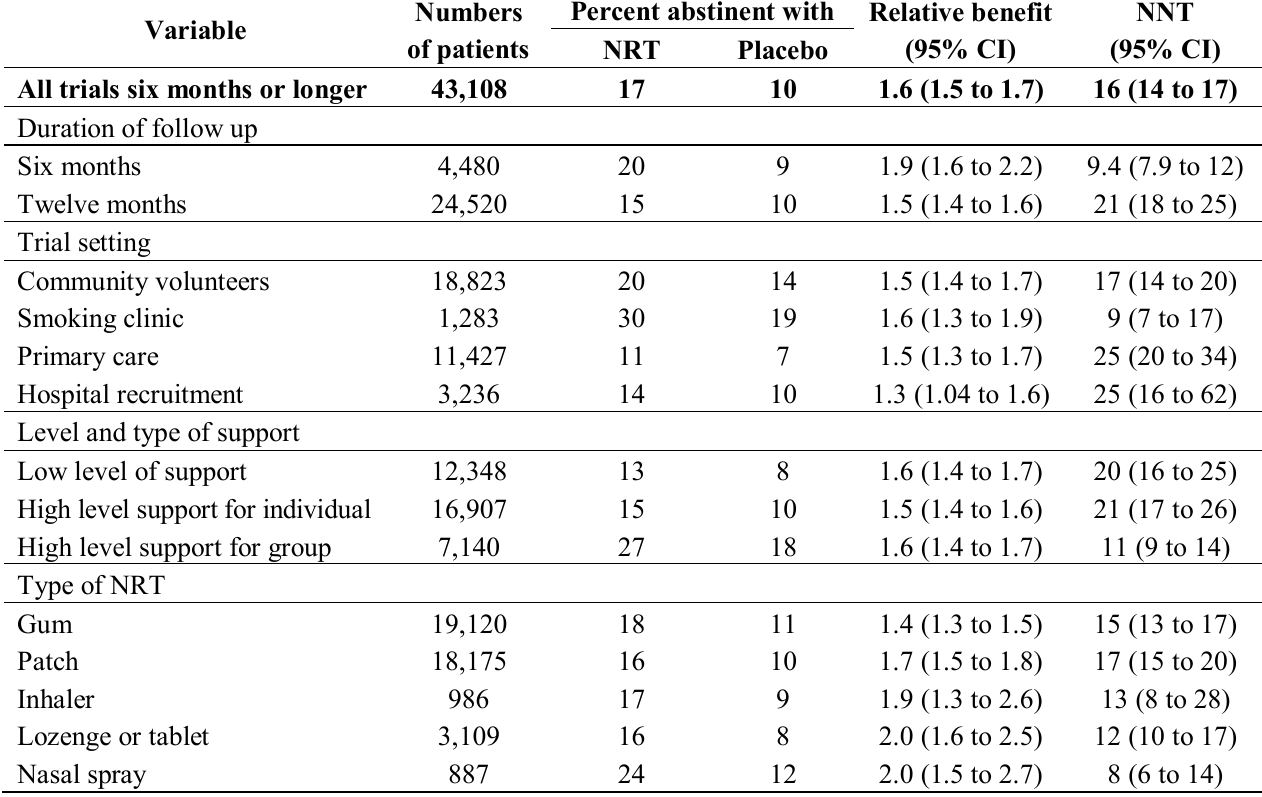
Table 3. Influence of variables in NRT trials on cessation rates with placebo. Intervention is as described in each review, and details of the reviews is in Table